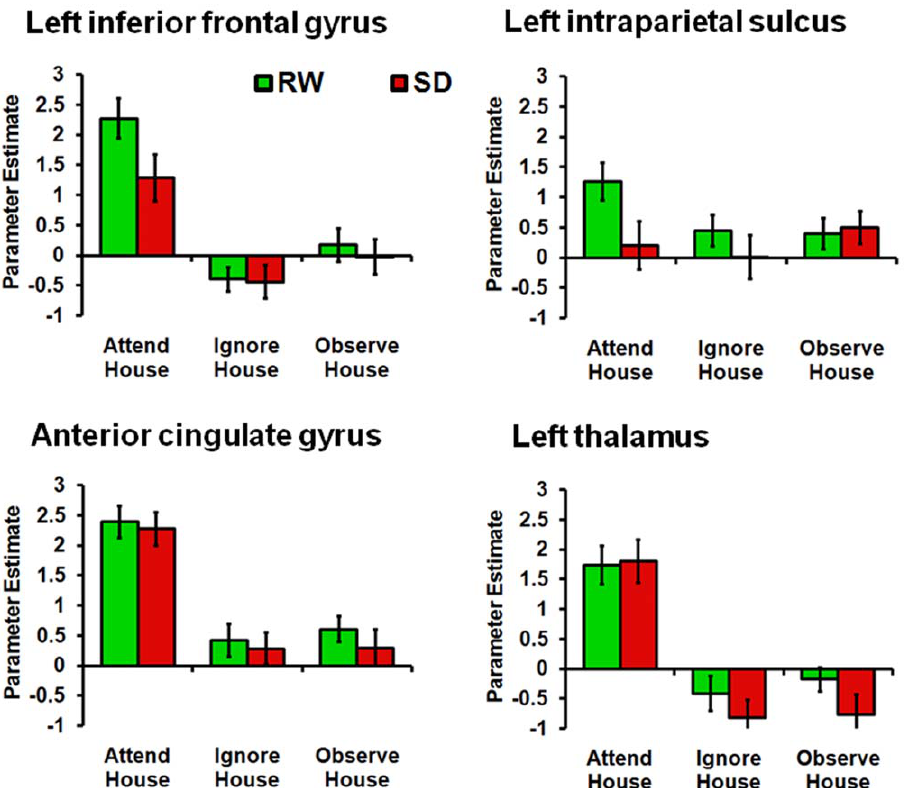
Figure 3. Parameter estimates of activation for the house conditions in areas associated with arousal and attention. Parameter estimates for each condition and state associated with the left inferior frontal gyrus (IFG), left intraparietal sulcus (IPS), anterior cingulate cortex (ACC), and left thalamus. Significant state-related differences were observed in the left IFG and IPS, but not in ACC or the thalamus.